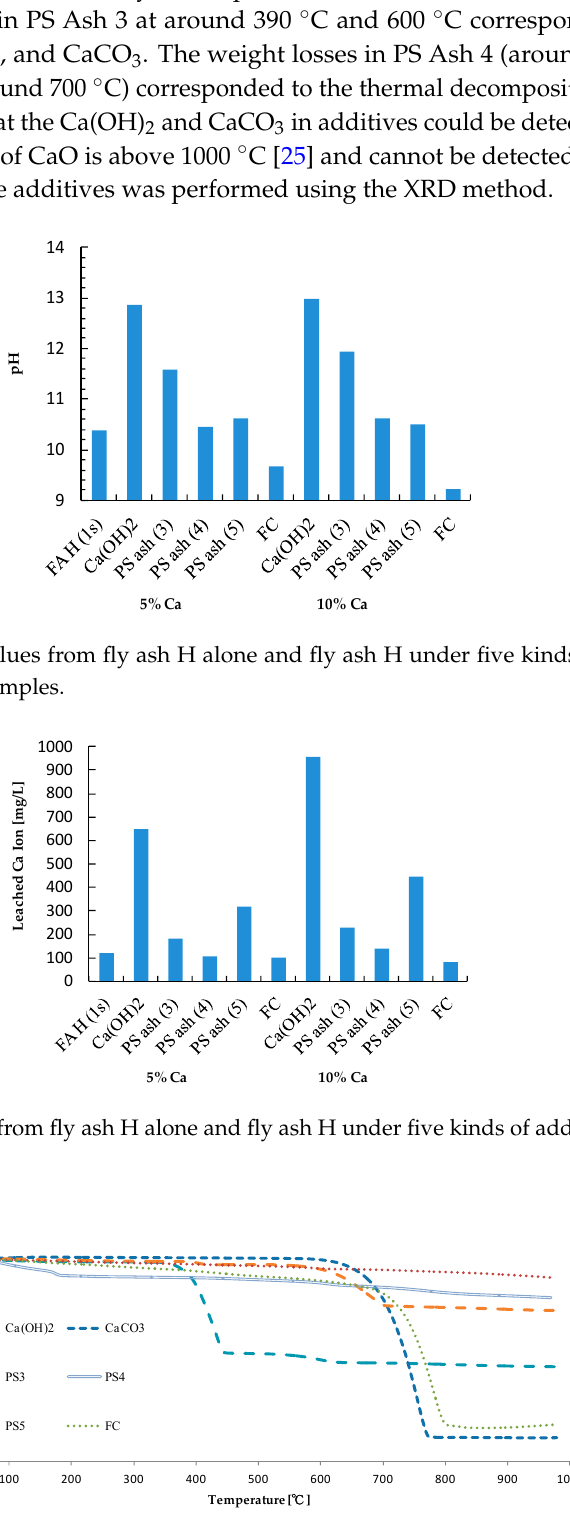
Figure 3. Thermogravimetric curves showing the thermal decomposition of Ca(OH) 2 , CaCO 3 , and additives in a N 2 atmosphere.